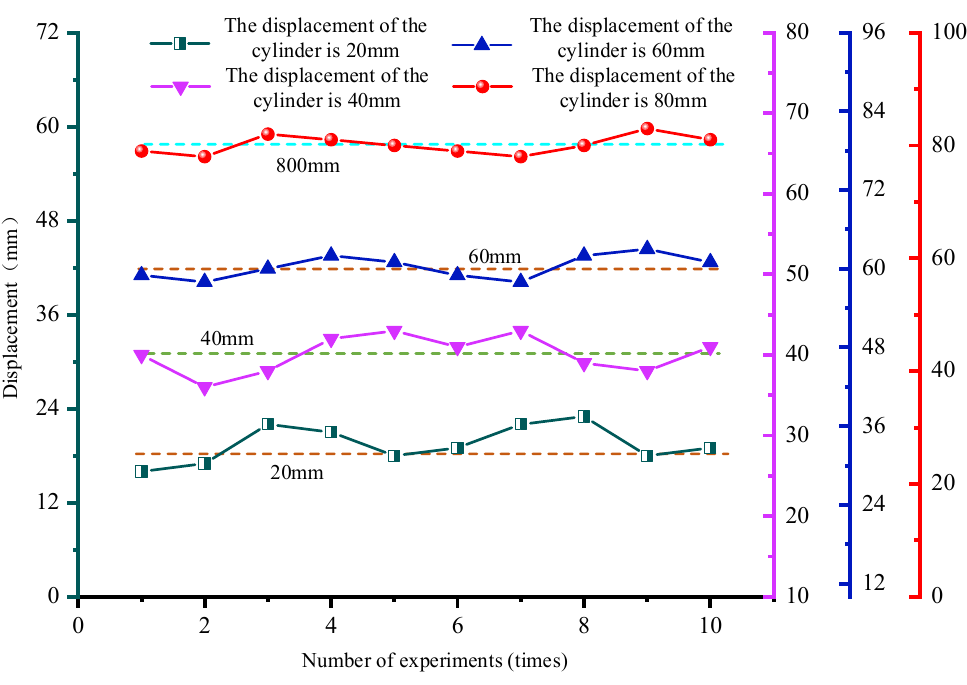
Figure 26. Displacement curve of the pushing cylinder of hydraulic support.